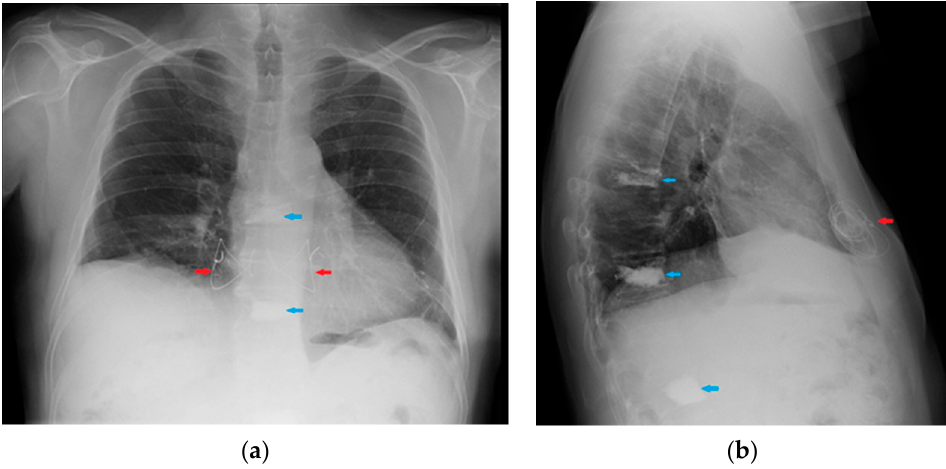
Figure 36. PA ( a ) and LL ( b ) CXR of a patient with sternal wires resulting from a transverse sternotomy (red arrows) and multiple outcomes of vertebroplasty (blue arrows).